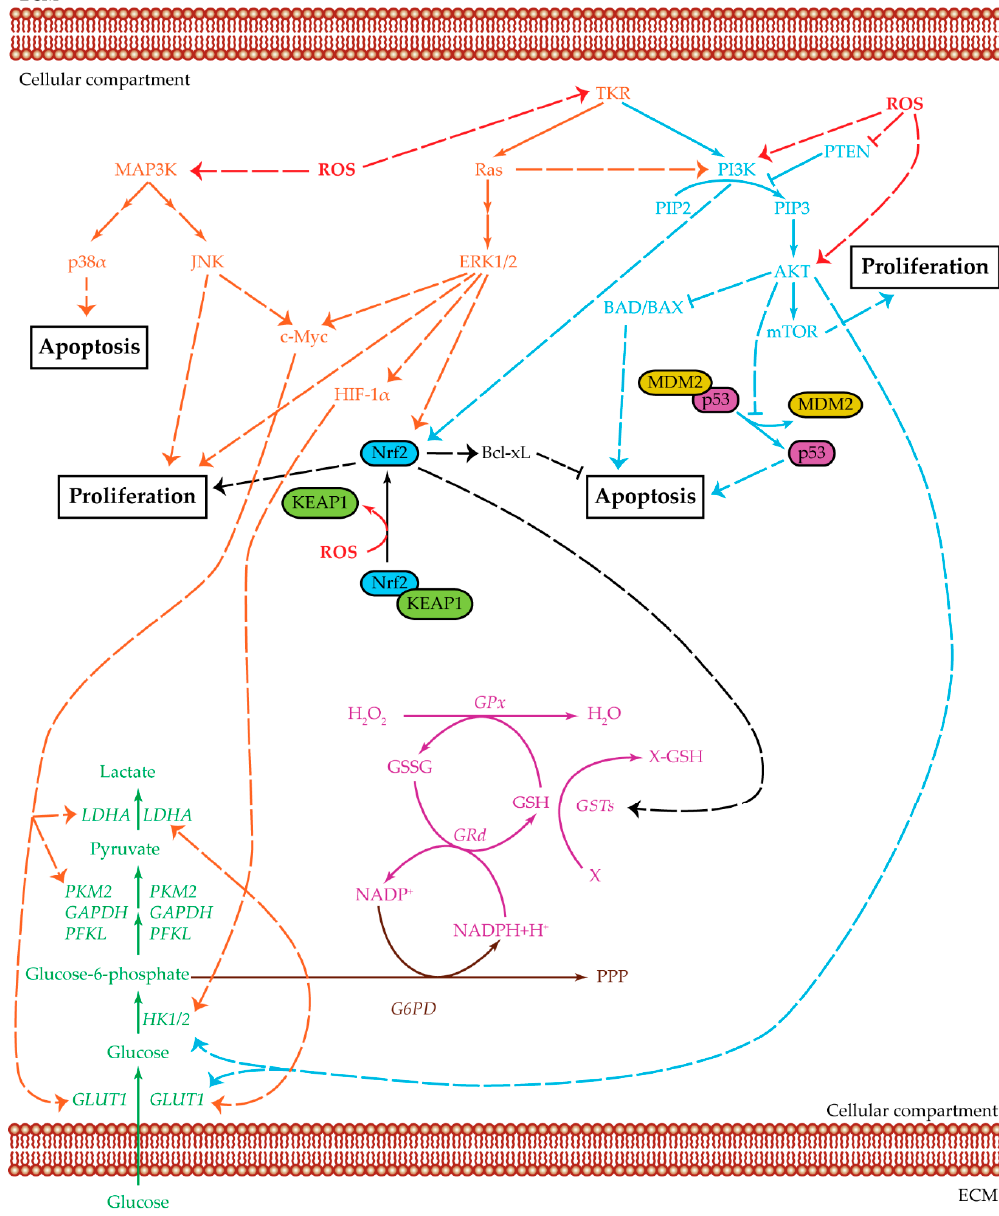
Figure 3. Crosstalk among glycolysis, MAPK, and PI3K pathways. Summarized are the three main pathways of cell proliferation and survival and the relevant cross-regulatory network: MAPK (orange), PI3K/AKT/mTOR (light blue), and glycolysis (green). Three related additional pathways are highlighted: glutathione cycle (purple), Nrf2 (black), and PPP (brown). Positive regulations are pictured as dotted arrows, and negative regulations are pictured as dotted truncated arrows. HCC cell survival is a complex mechanism that involves several cellular pathways which act both in single ways and as intersected signaling cascades. MAPK and PI3K/AKT/mTOR can be activated by tyrosine-kinase receptors to upregulate cell proliferation. They also act as inhibitors for cellular apoptosis. Ras protein, an effector of the MAPK pathway, can positively regulate PI3K, which increases AKT levels. AKT, in turn, upregulates both HK2 and GLUT1, thus favoring the glycolysis cascade. PI3K and ERK1/2 can positively regulate Nrf2, thus further increasing the signals for cellular proliferation. The upregulation of Nrf2 increases the GST levels which, in turn, maintains the ROS balance in a state favoring cell survival. The GST enzyme is part of the glutathione cycle and it acts with GSH as detoxification agent against oxidative byproducts. GSH and GSSG levels are regulated by GPx, an enzyme mainly used